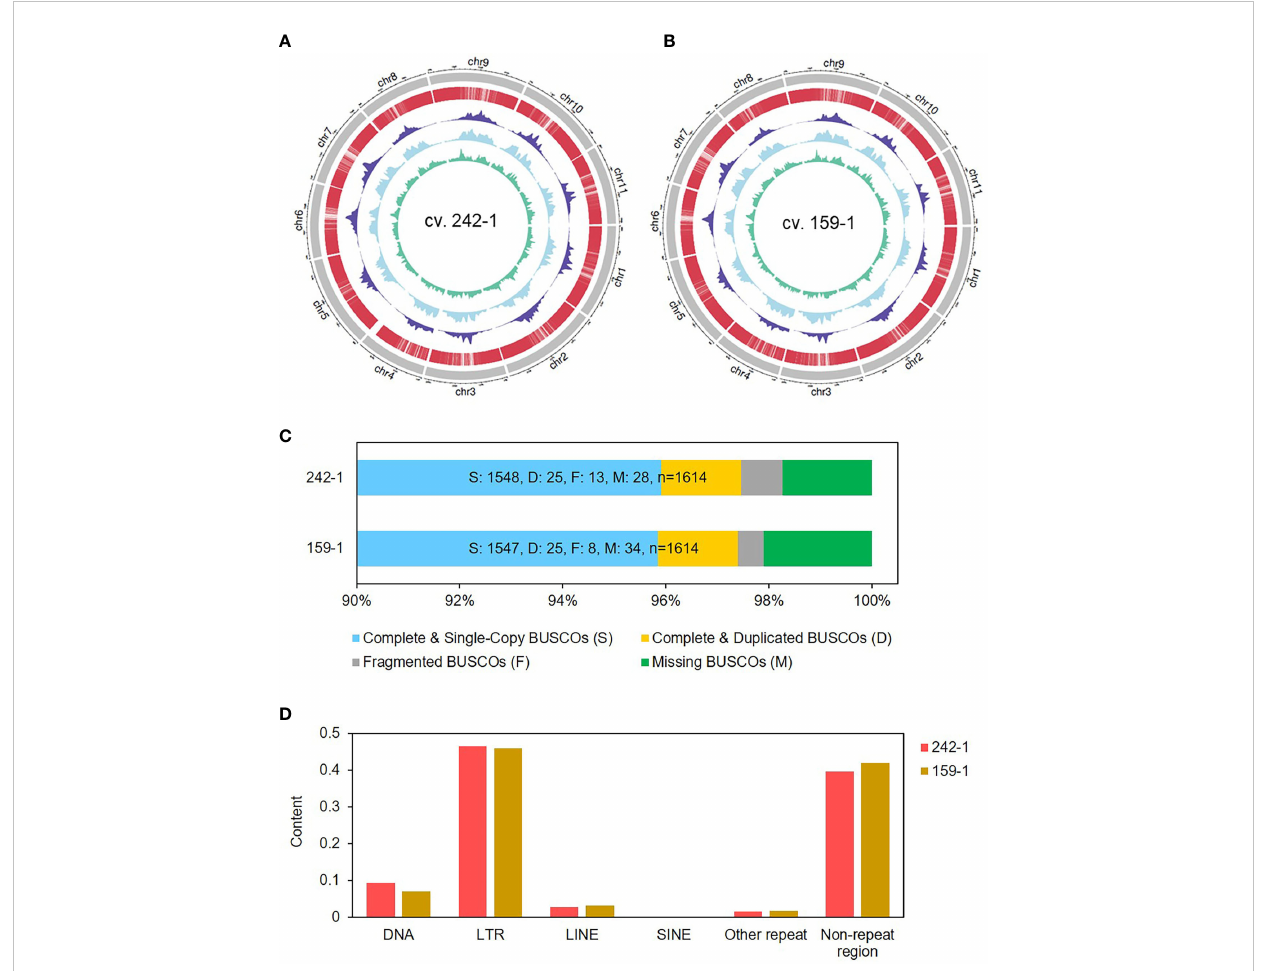
FIGURE 2 Genome characterization of the two inbred parental watermelon lines. (A, B) The outermost circle is the ideogram of 11 chromosomes in Mb scale, enclosing concentric circles of gene distribution (red), Gypsy content (navy blue), Copia content (sky blue), and DNA transposon content (green) in 1-Mb scale. (C) BUSCOs of the assembled watermelon genomes analyzed by using BUSCO v4.1.4 software. (D) Repetitive contents of the watermelon genomes analyzed by Repeat Masker with